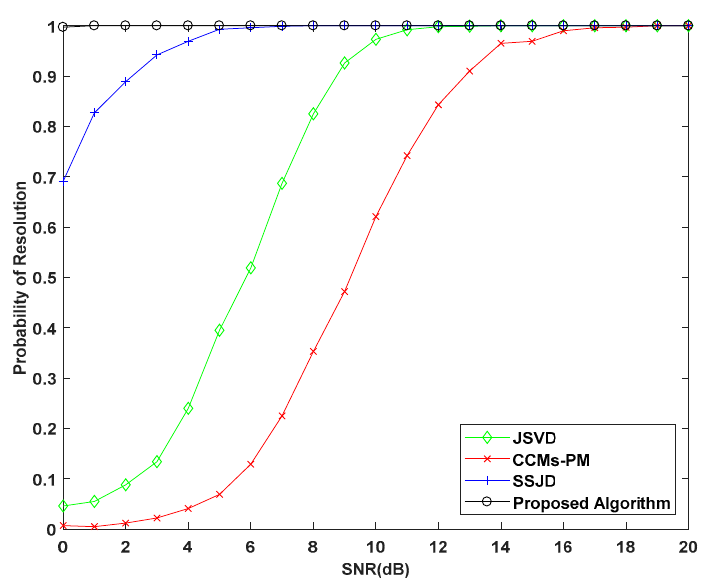
Figure 6. RMSE performance versus signal-to-noise-ratio (SNR) for simulations with 100 snapshots.